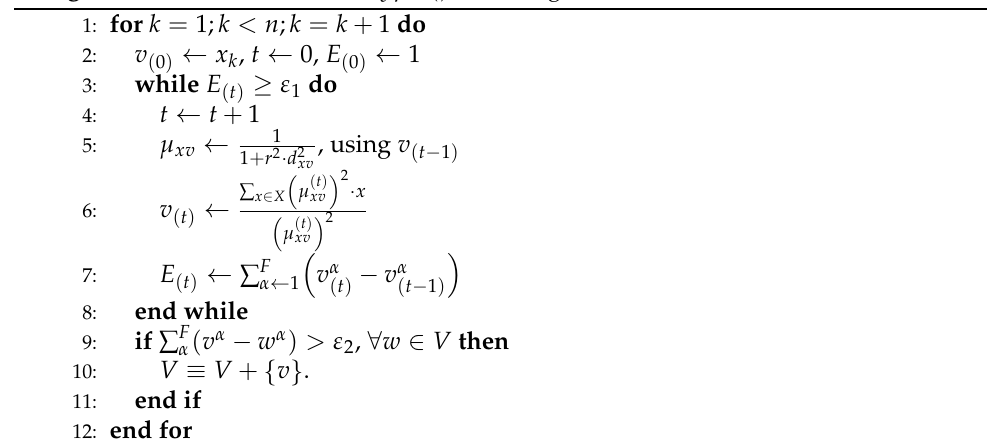
Algorithm 5: Calculate _ Prototypes () of FM